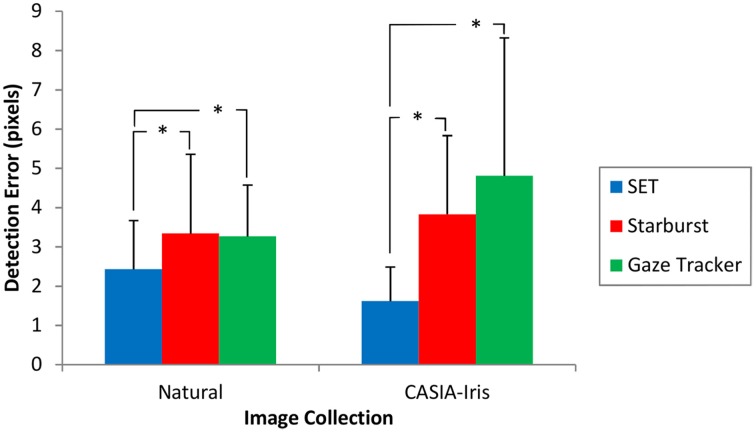
Detection error for different methods and image collections after exclusion of missed frames. Error bars reflect one standard deviation. *p < 0.001.